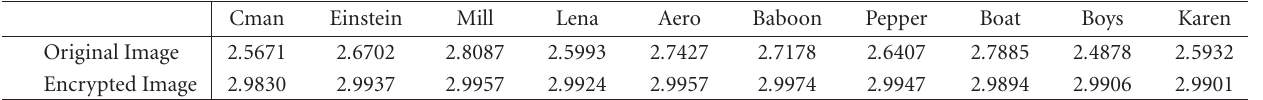
Table 2: The fractal dimensions of the original and encrypted images. Cman